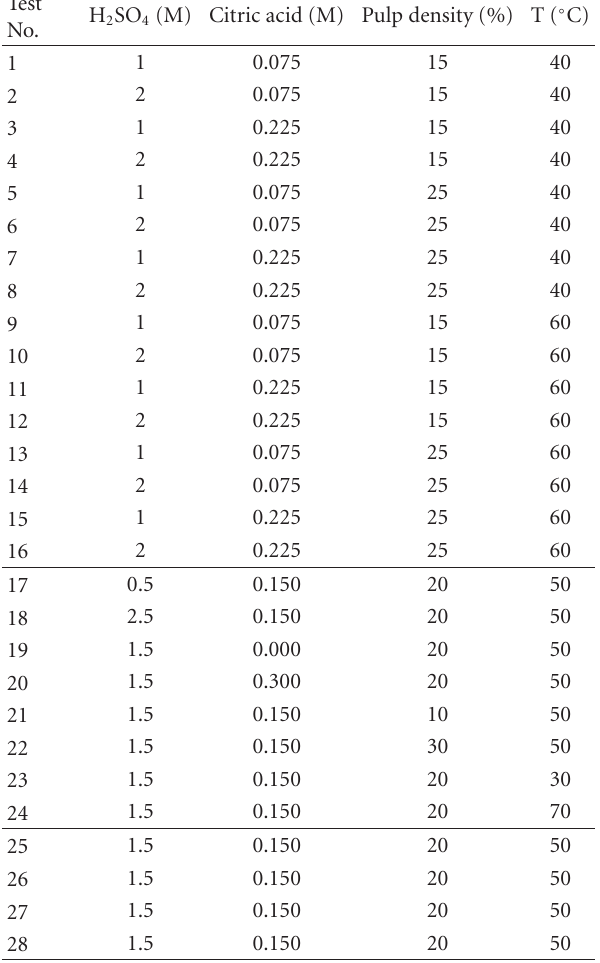
Table 2: Levels of factors investigated in the second series of leaching tests.